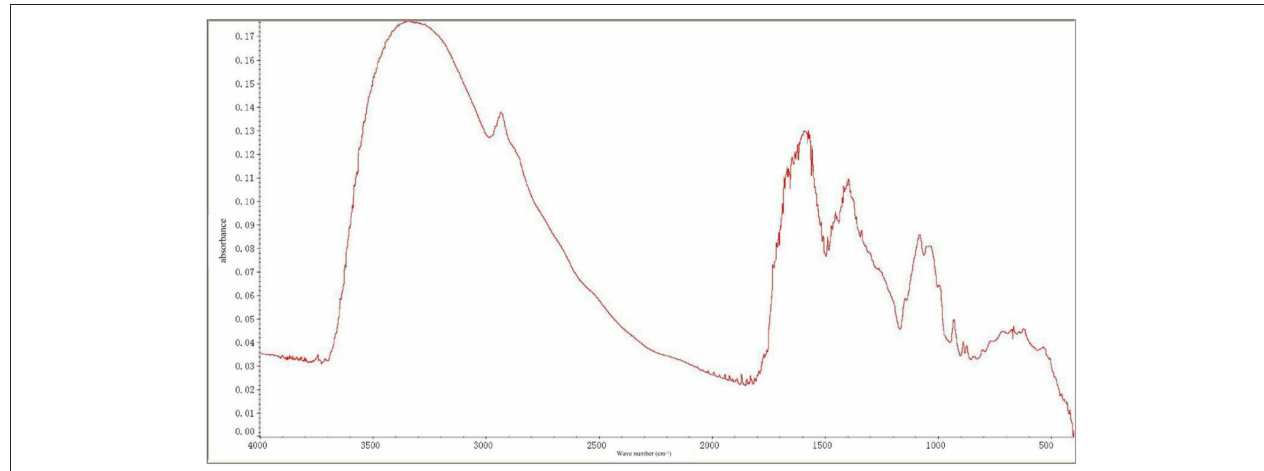
FIGURE 1 | Fourier-transform infrared spectra of Morchella importuna polysaccharides (MIPs).